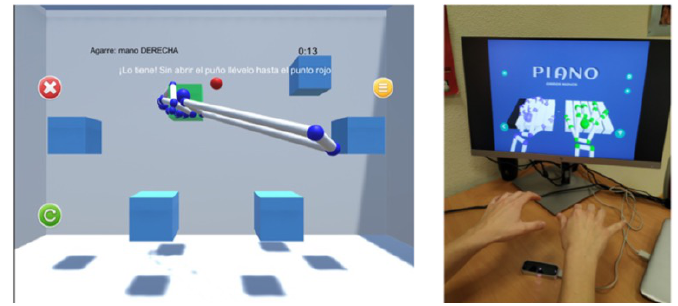
Fig. 6. Left) Grab Game; Right) Piano Game (Cuesta-Gómez et al., 2020)